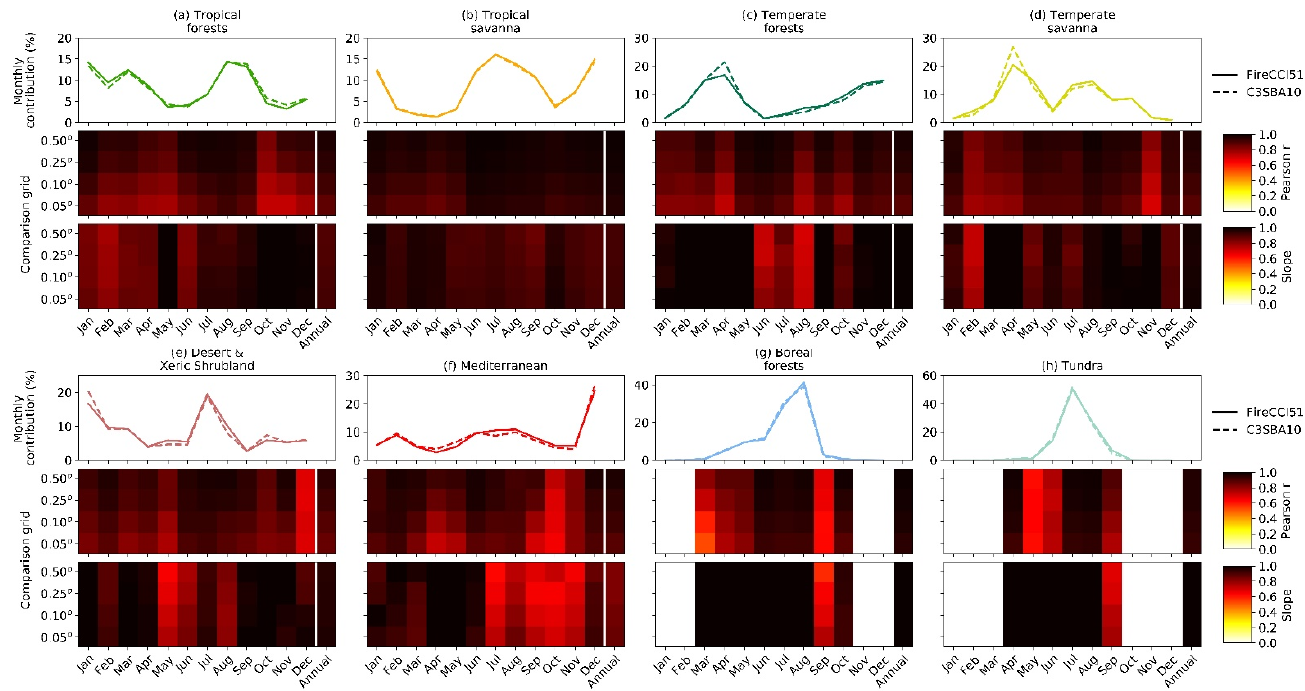
Figure 7. Monthly percent BA contribution, Pearson’s correlation and bias (slope) between the FireCCI51 and C3SBA10 products per biome (sub-figures ( a – h )) and grid size for the year 2019. Table 5. Accuracy metrics for the years 2017, 2018 and 2019. Standard errors are shown between